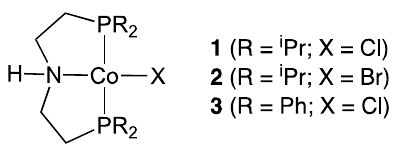
Figure 1. Depiction of complexes 1 – 3